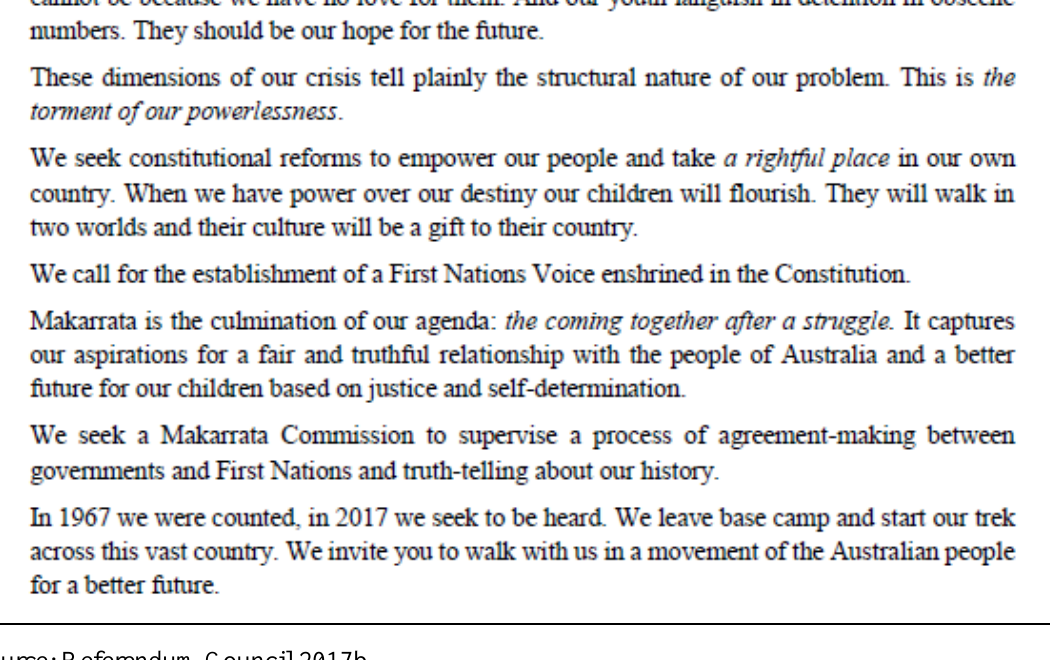
Figure 2: Uluru Statement from the Heart, May